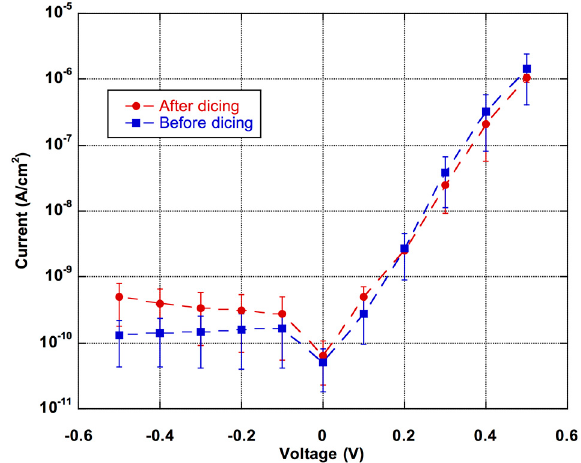
Figure 4. Current voltage characteristics of the a-Si:H photodiodes before (blue squares) and after (red circles) the dicing process. Symbols and bars refer, respectively, to the averaged values and to the standard deviations measured over five photodiodes.